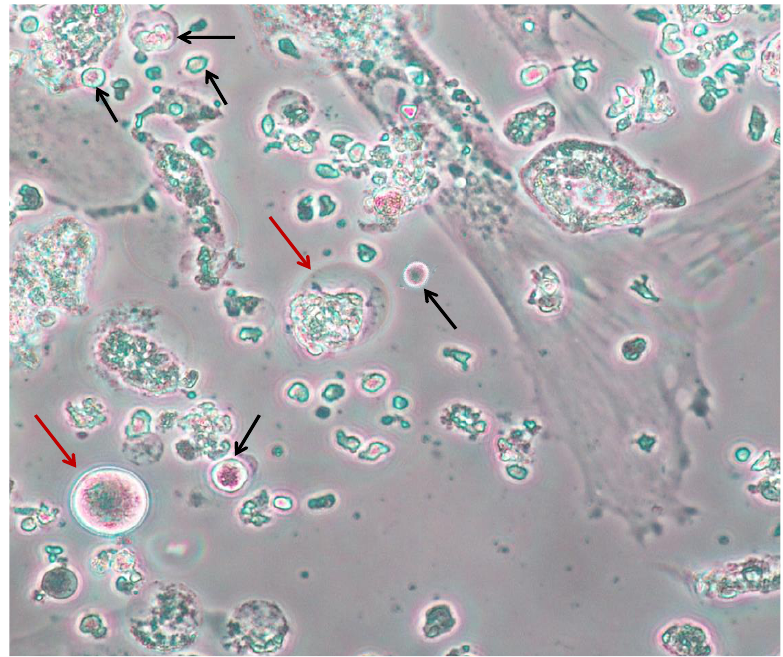
Figure 4. In vitro maturation of ovarian stem cells (OSC)s to oocyte-like cells (OLCs) of large (red arrows) and small (black) size in three weeks cultures.